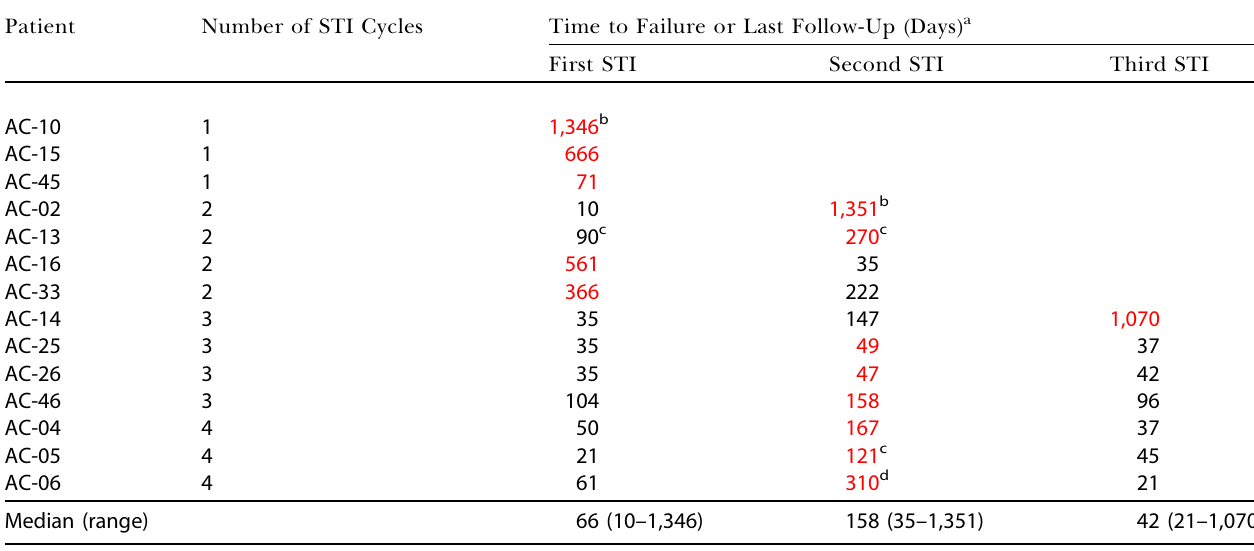
Table 3. Time to Failure during the STIs